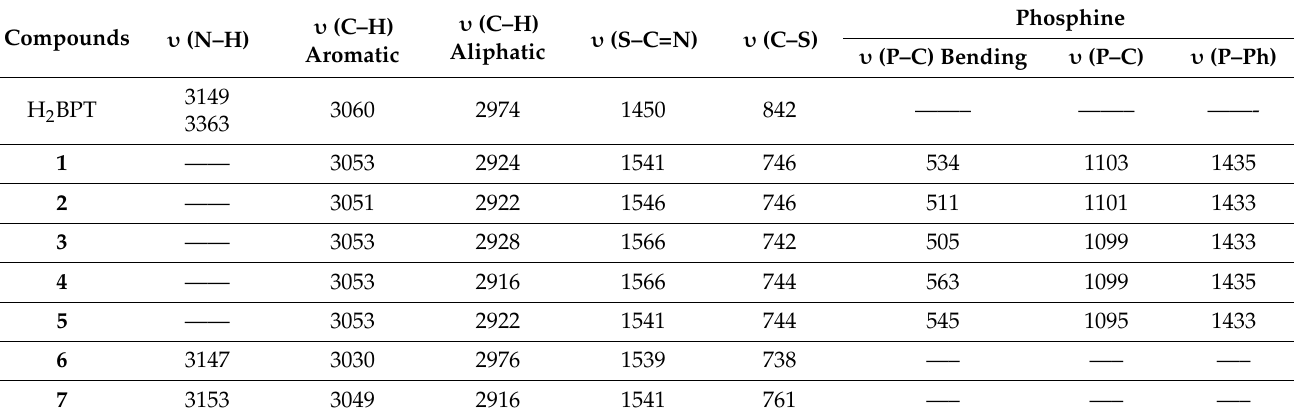
Table 2. Characteristic peaks in the IR spectra for the synthesized complexes ( 1 – 7 ) and the ligand H 2